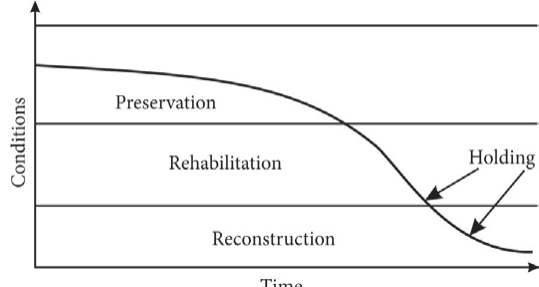
Fig. 8. Types of pavement maintenance strategy